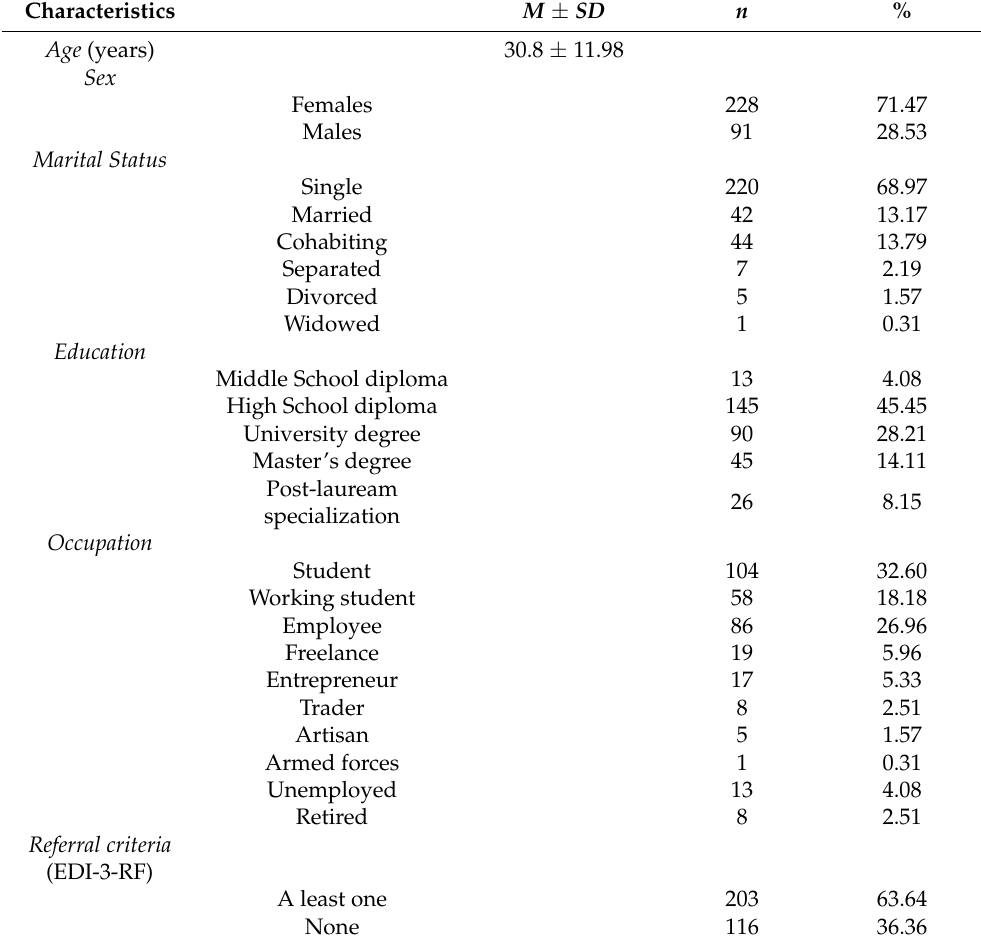
Table 1. Demographic characteristics of the sample ( N = 319).